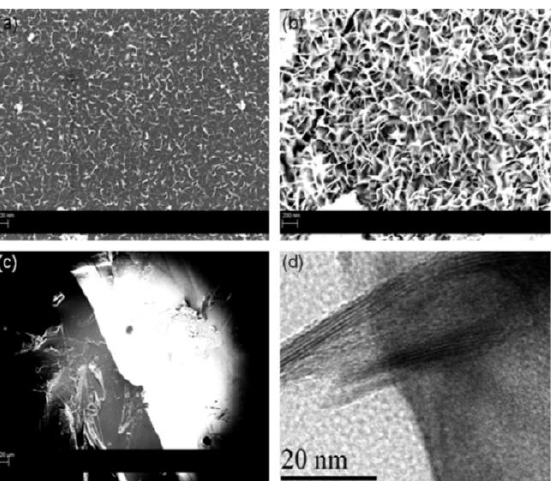
Figure 25. Electric-field-assisted laser ablation in liquids. SEM of CNW deposited after ( a ) 20 min and ( b ) 2 h ablation. ( c ) The dipping interface and ( d ) an HRTEM image of the walls. Reprinted with permission from Ref. [54]. 2012, Elsevier.